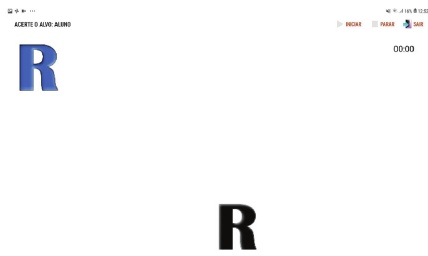
Figure 10: Hit-the-target